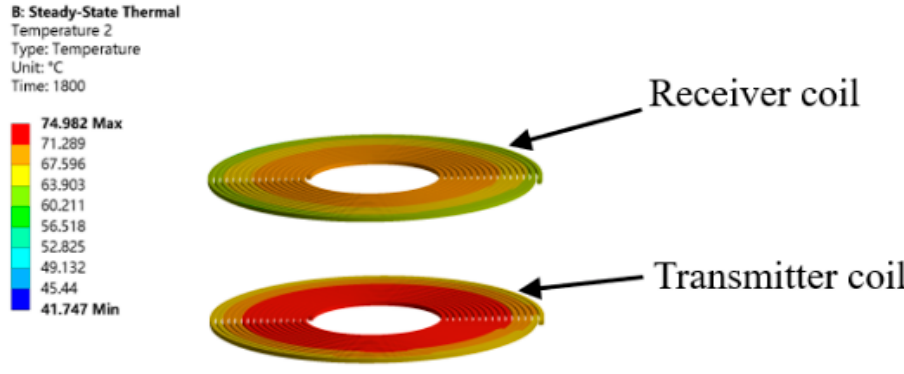
Figure 8. Temperature cloud of the coil Figure 8 . Temperature cloud of the coil section.